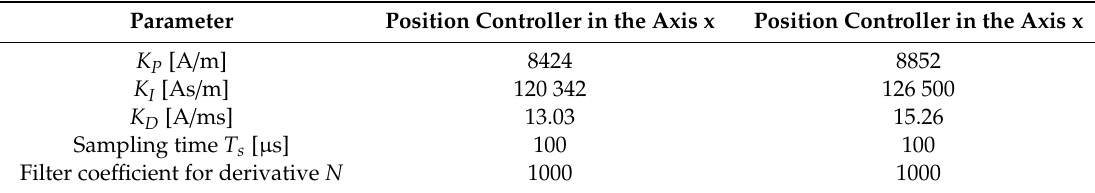
Table 3. Parameters of the position controllers.